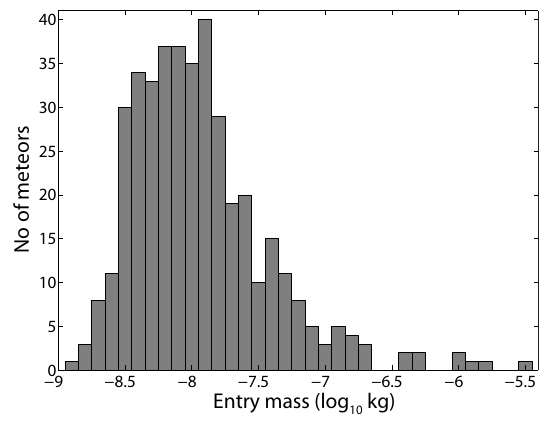
Fig. 8. Distribution of the monostatic RCS measured in Tromsø for the 265 meteors appearing inside the –3 dB beamwidth and a scatter plot of the velocity versus RCS. The RCS is expressed as dB relative to a square metre (dBsm).